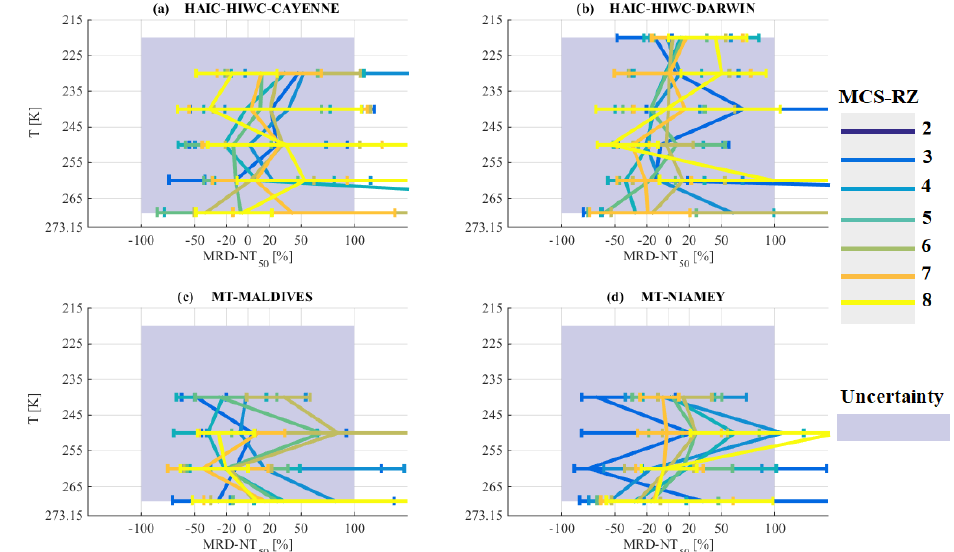
Figure 10. The same as Fig. 6 but for MRD-NT 50